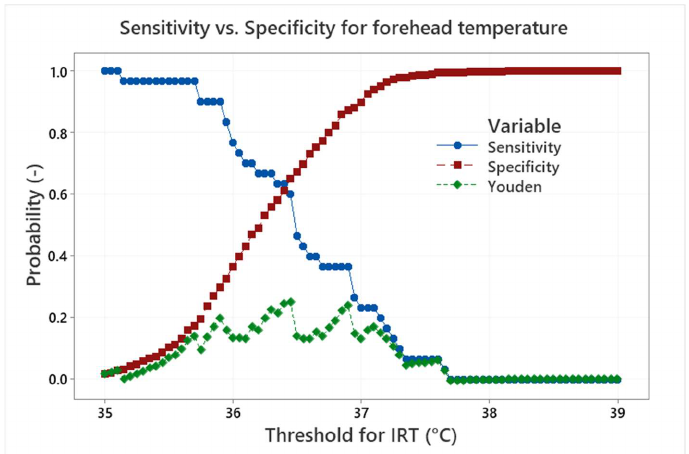
Figure 15. Sensitivity, specificity and Youden index curves for the forehead temperature and the APT threshold of 36.5 °C.